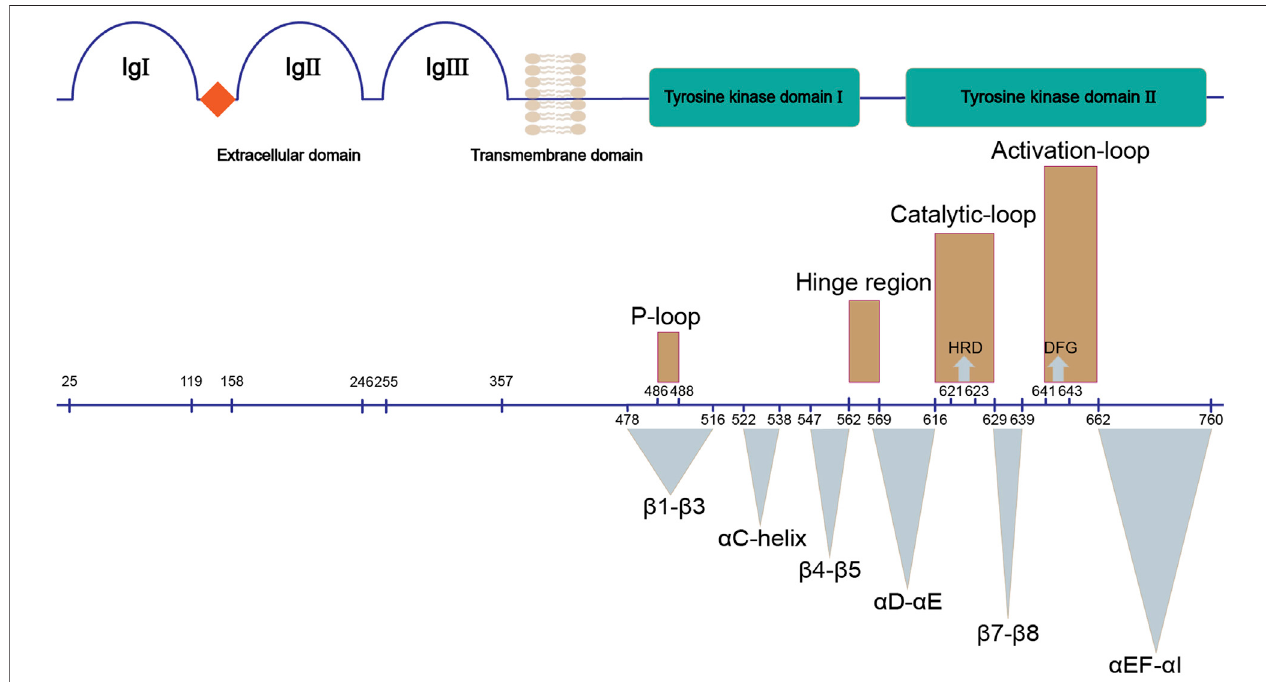
FIGURE 1 | Structure of FGFR. The upper panel shows the main domains of FGFR; the bottom panel demonstrates their corresponding sequences (UniProtKB: P11362). Three dimensional structures (brown) and functional regions (cyan) involved in the kinase domain of FGFR are marked.